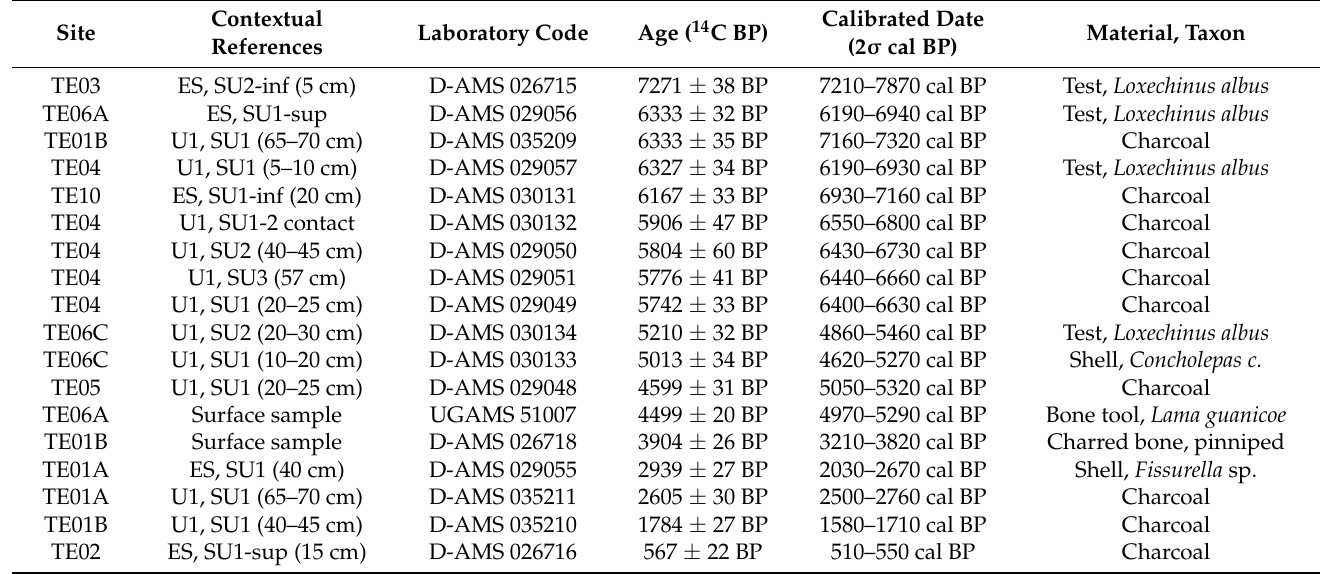
Table 1. Radiocarbon chronology of El Teniente